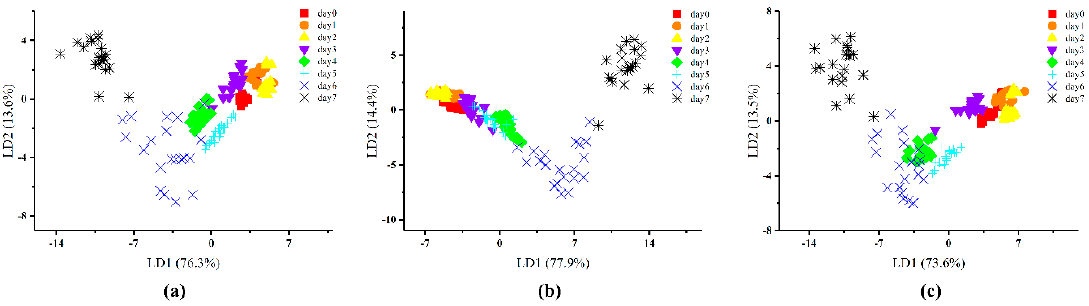
Figure 2. Linear discriminant analysis (LDA) by ripening day based on three different feature extraction methods: ( a ) the max/min values; ( b ) the difference values; ( c ) the 70th s